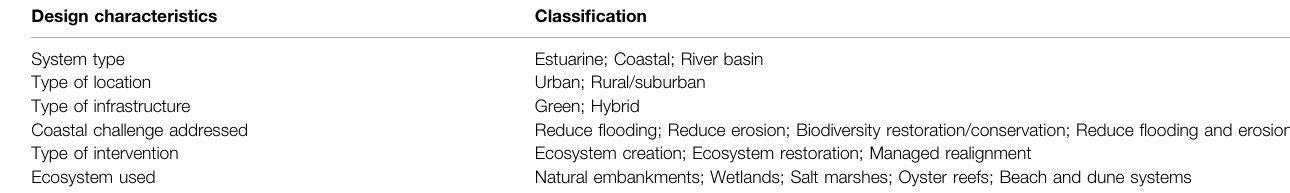
TABLE 2 | Design characteristics (left) and classi fi cation per characteristic